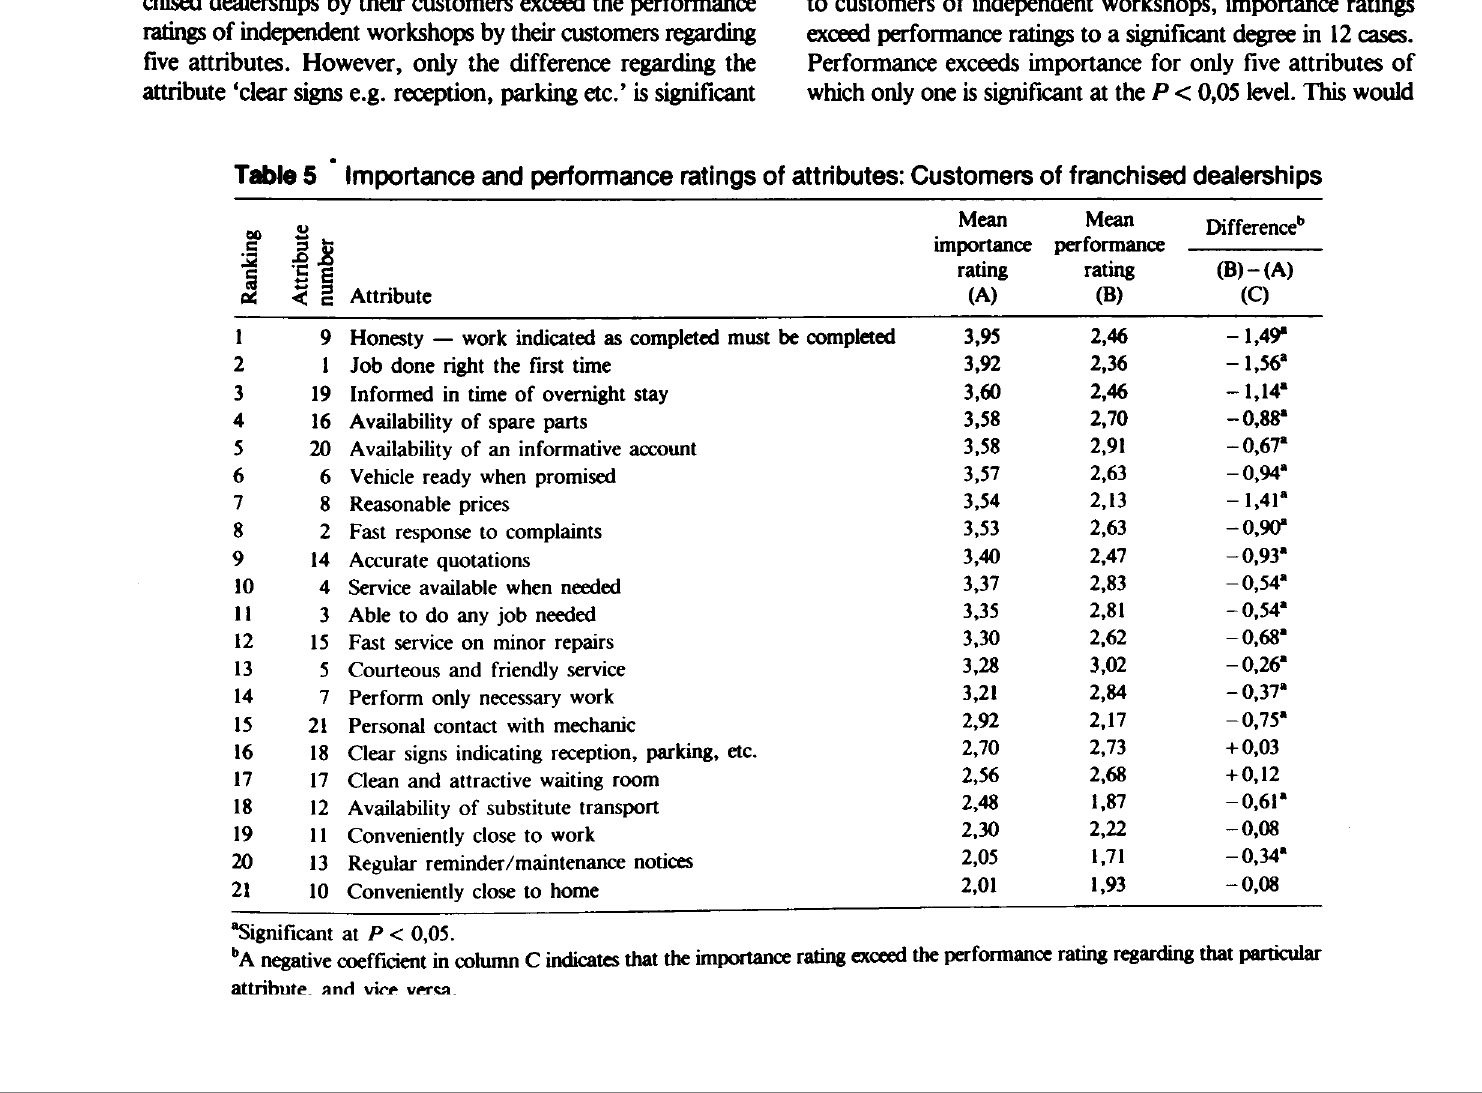
Importance and performance ratings of attributes: Customers of franchised